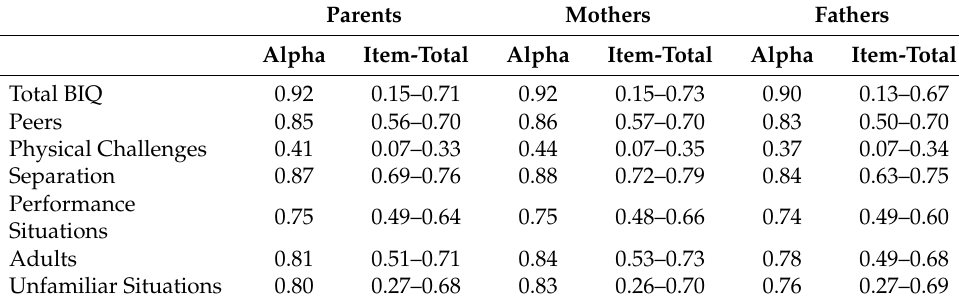
Table 5. Cronbach’s Alphas and Item-Total correlations for parents, and for mothers’ and fathers’ forms